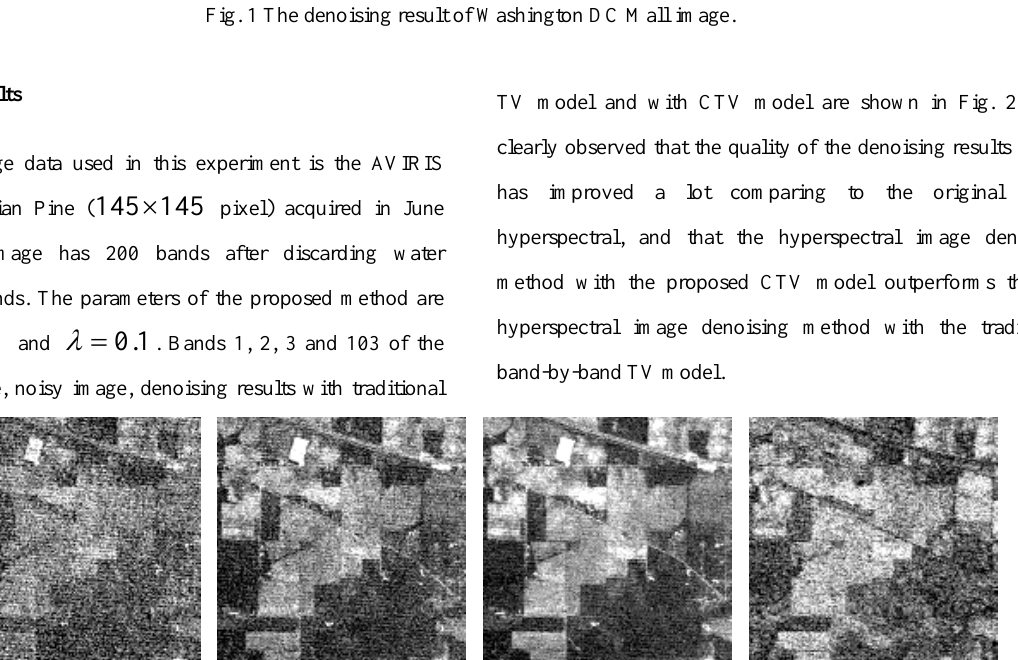
Fig. 1 The denoising result of Washington DC Mall